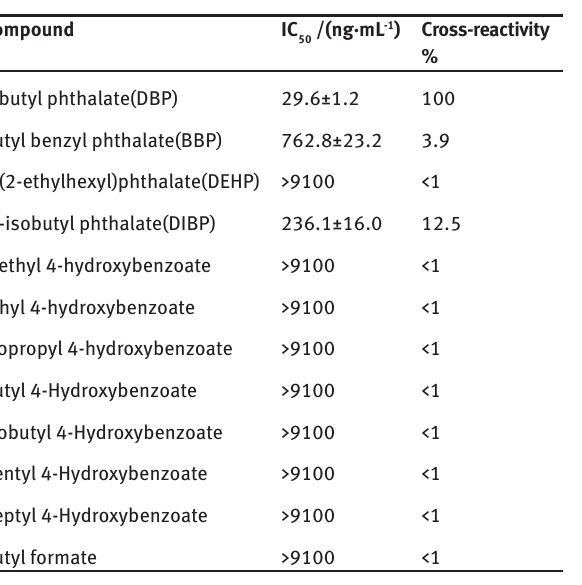
Table 2: Cross reactivity for ELISA kit analysis of DBP analogue.